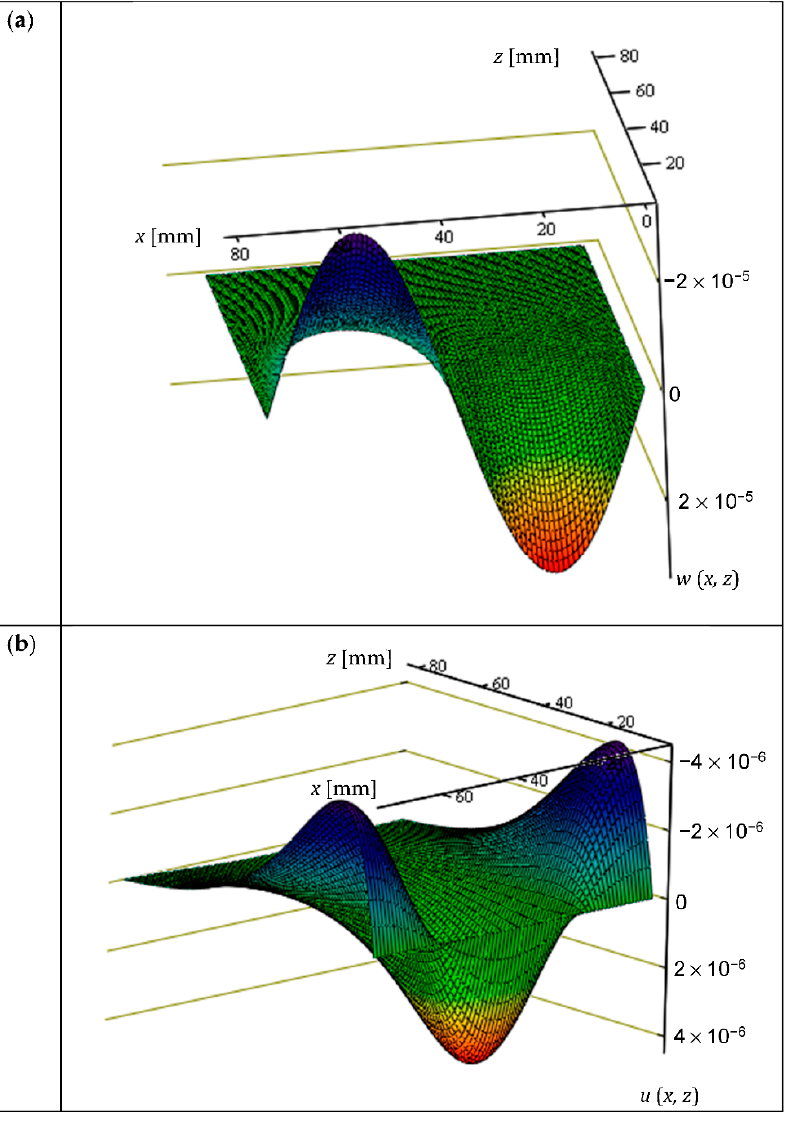
Figure 3. Solution obtained by using the differential equation method: ( a ) vertical displacement w ( x , z ), ( b ) horizontal displacement u ( x , z ).